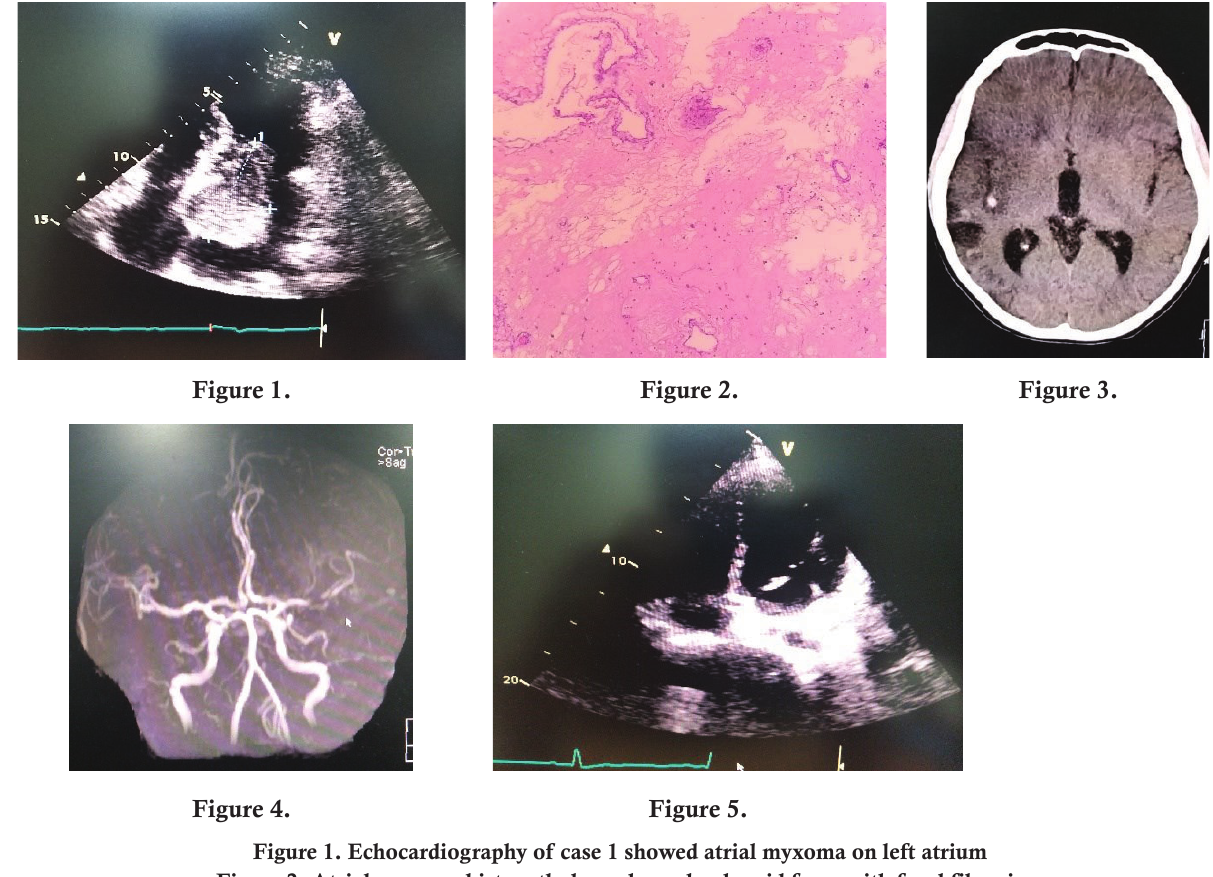
Figure 1. Echocardiography of case 1 showed atrial myxoma on left atrium Figure 2. Atrial myxoma histopathology showed polypoid form with focal fibrosis Figure 3. CT scan of case 2 showed multiple hyper-acute lacunar infarct on the left cerebellum Figure 4. MRA brain of case 2 showed occlusion on middle cerebral artery Figure 5. Echocardiography of case 2 showed left atrial myxoma